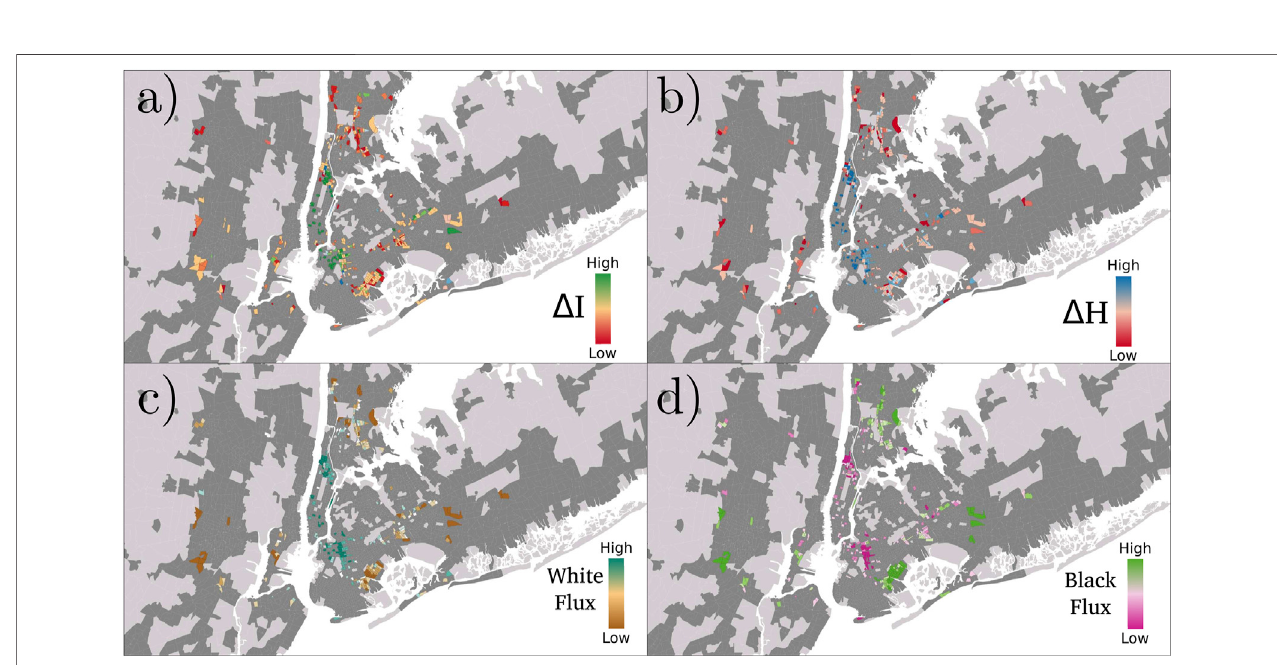
FIGURE8| Segregationbetweenwhiteandblack. (A) thevariationofthepercapitaincome, (B) thevariationofthepropertiesvalues, (C) theincoming fl uxofwhite, and (D) the incoming fl ux of black for the tracts that migrated from one zone to another or to the Overlap zone from 1990 to 2010.